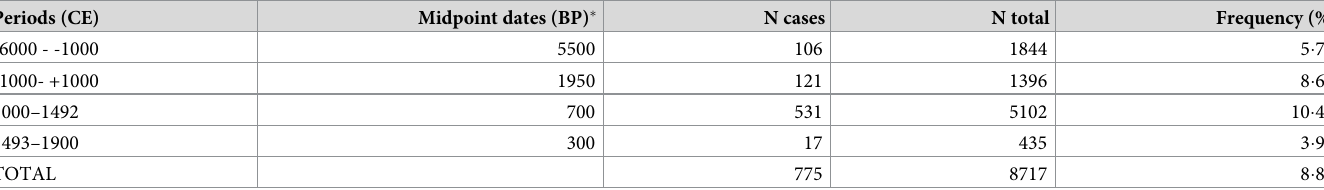
� rounded to full/mid